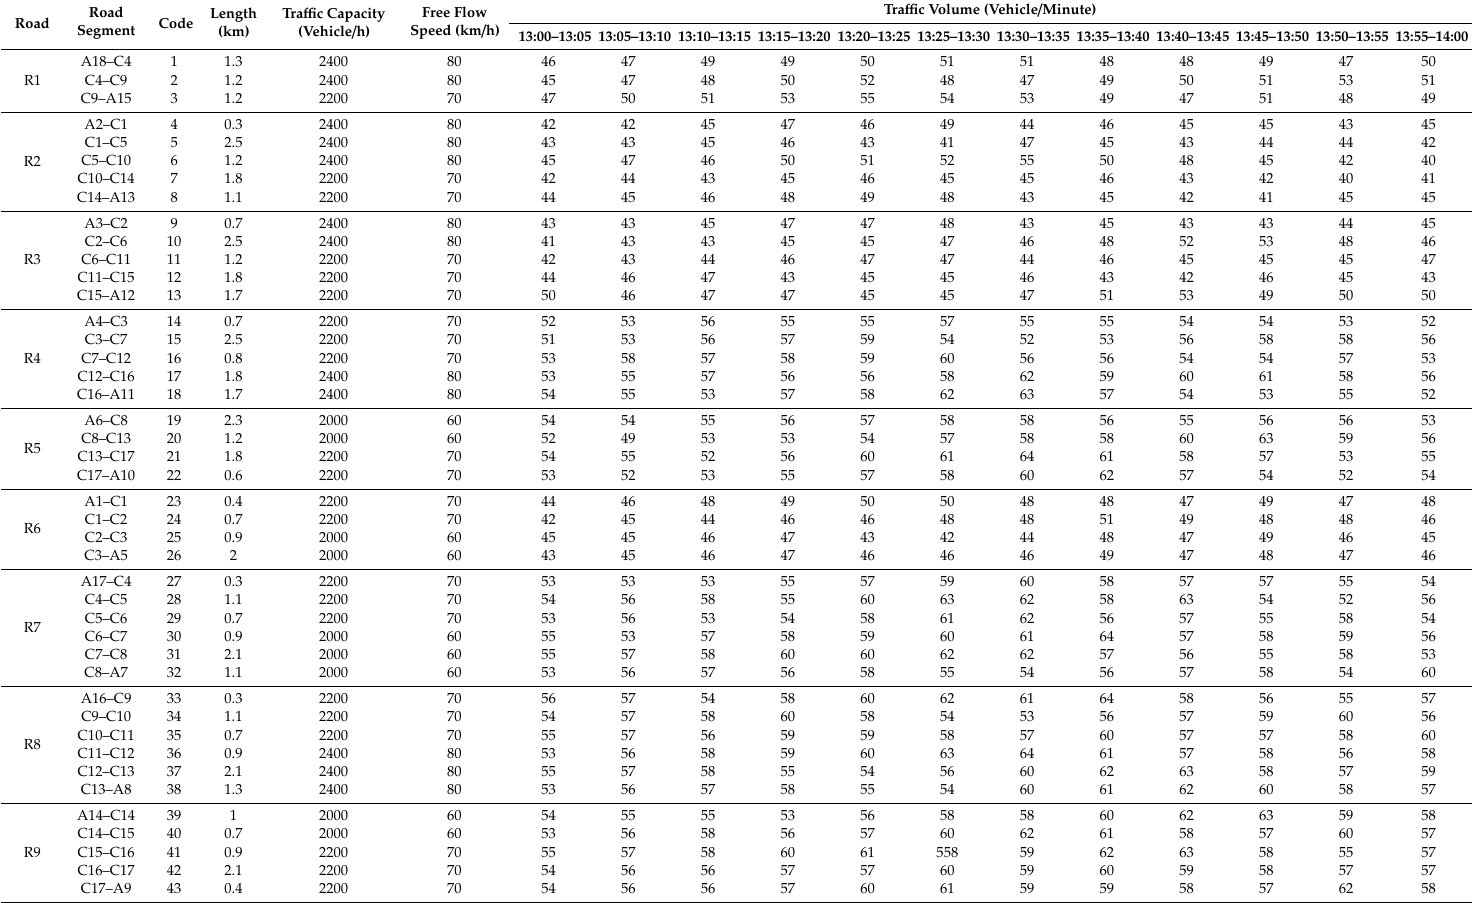
Table A1. Data of the road network and tra ffi c